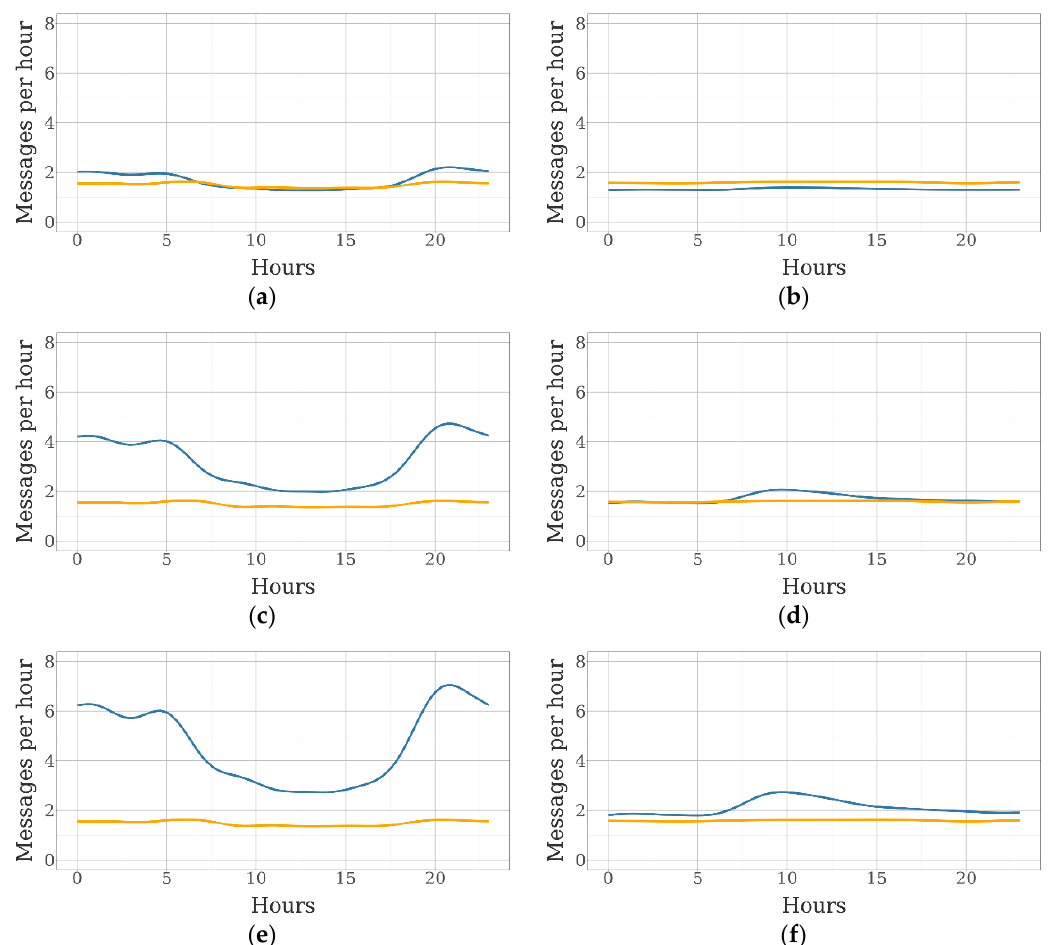
Figure 6. Evolution of the number of messages received hourly from GPS collars (orange lines) and BLE tags (blue lines) over the day: ( a ) messages from the sheep farm with five collars and 25 tags; ( b ) messages from the beef cattle farm with five collars and 25 tags; ( c ) messages from the sheep farm with 15 collars and 25 tags; ( d ) messages from the beef cattle farm with 15 collars and 25 tags; ( e ) messages from the beef cattle farm with 25 collars and 25 tags; and ( f ) messages from the beef cattle farm with 15 collars and 25 tags.